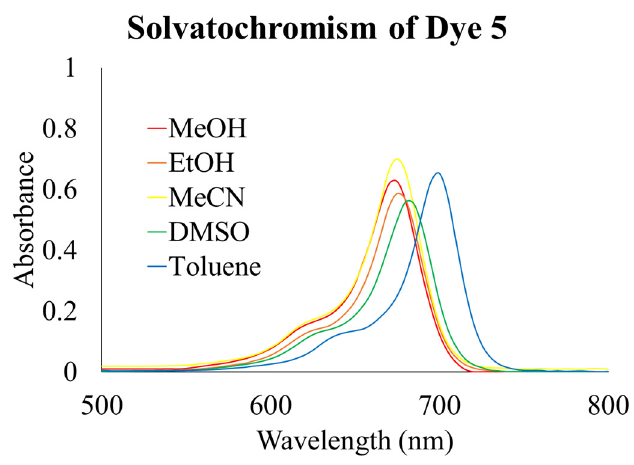
Figure 2. Solvatochromism of compound 5 (3 µM) in five different solvents: Methanol (MeOH), Ethanol (EtOH), Acetonitrile (MeCN), Dimethyl Sulfoxide (DMSO), and Toluene.